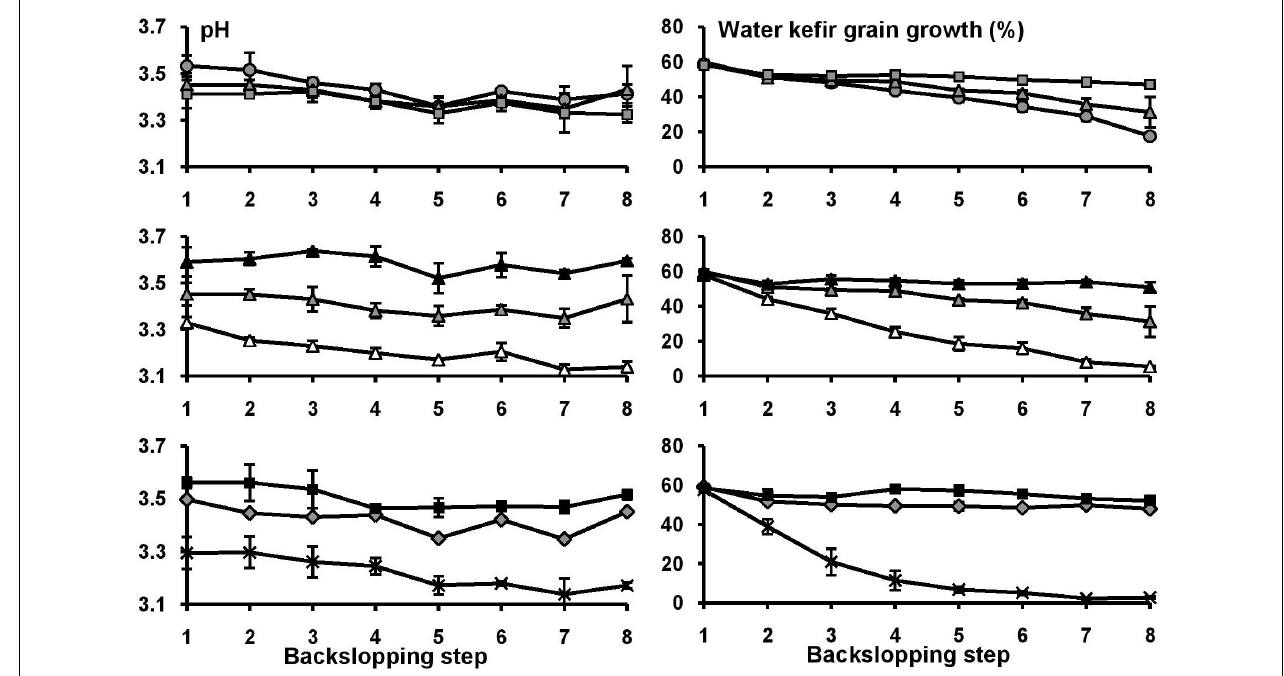
FIGURE 3 | The pH and water kefir grain growth at the end of each backslopping step for eight water kefir fermentation series differing in the buffer capacity and calcium concentrations of the water used for fermentation: increasing calcium concentrations [1B0Ca ( capacity [0B1Ca ( (cid:49) ), 1B1Ca ( (cid:78) ), and 2B1Ca ( (cid:78) )] (middle) ; and high buffer capacity and calcium concentration [2B4Ca ( (cid:4) )], low buffer capacity and calcium concentration [0B0Ca (X)], and tap water [TAP ( (cid:7) )] (bottom) . For differences of significance, see Supplementary Tables S2, S3